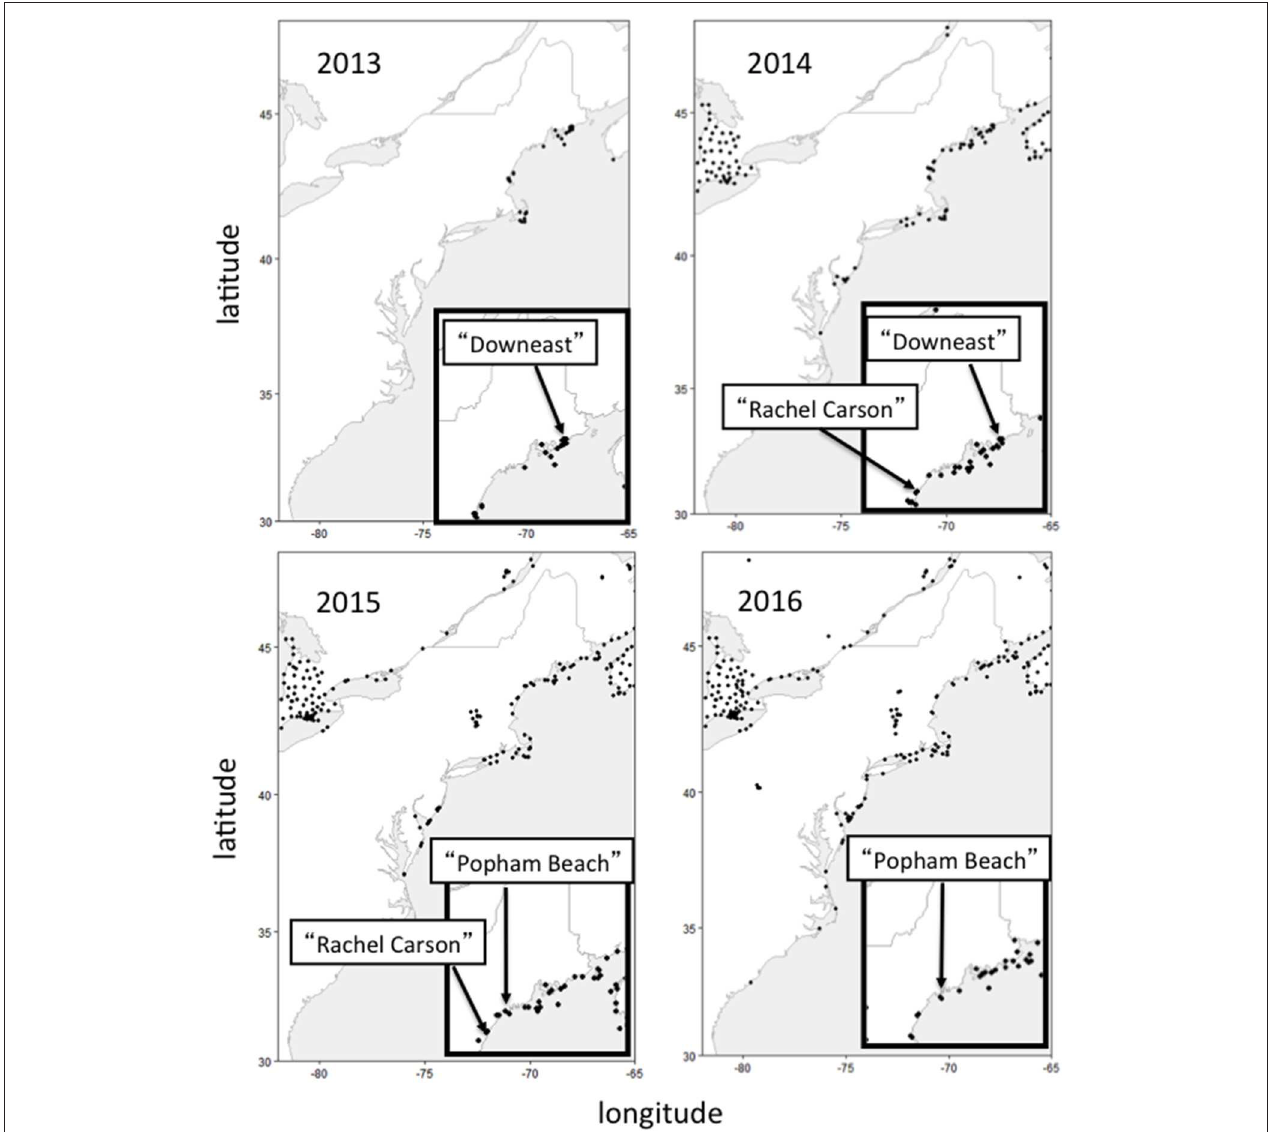
FIGURE 1 | Location (solid circles) of individual automated VHF telemetry towers, comprising the Motus Wildlife Tracking Array, that were active during each year in which tagging activities occurred in Maine. Insert maps show the specific locations (see text for detailed description) where Semipalmated Sandpipers were captured and tagged each year (see text for detailed description of each site’s topography, levels of human activity, and the towers designated as “local”).